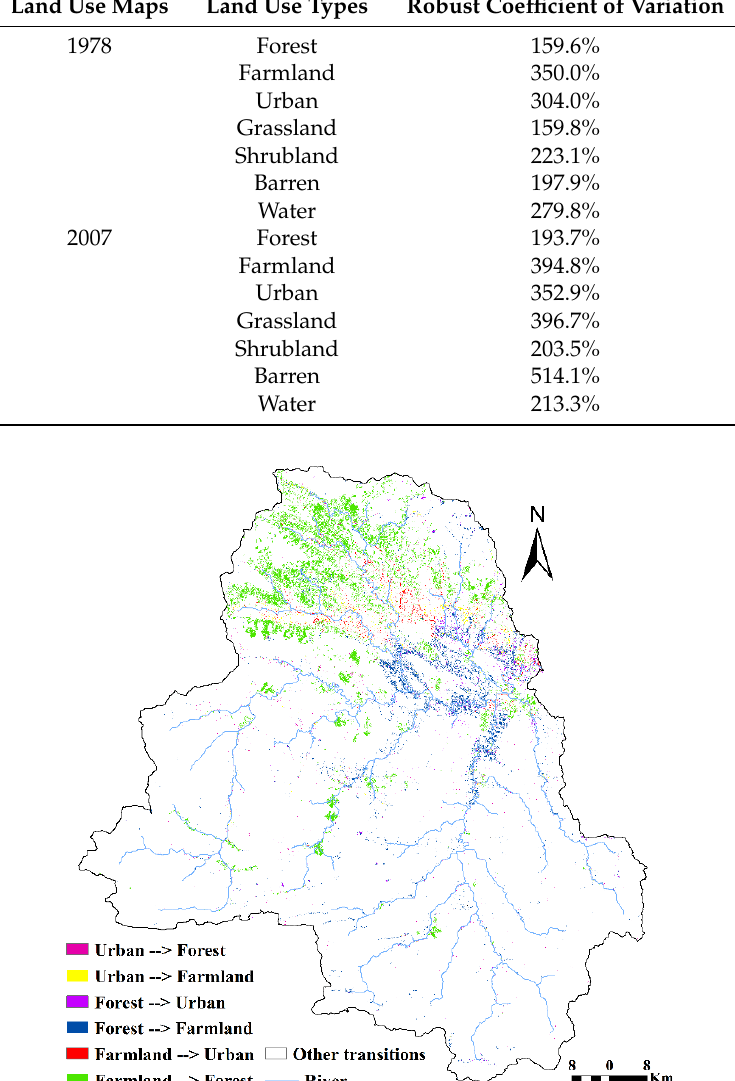
Table 5. Robust Coefficient of Variation for the land use types of each sub-watershed in Upper Du Watershed.